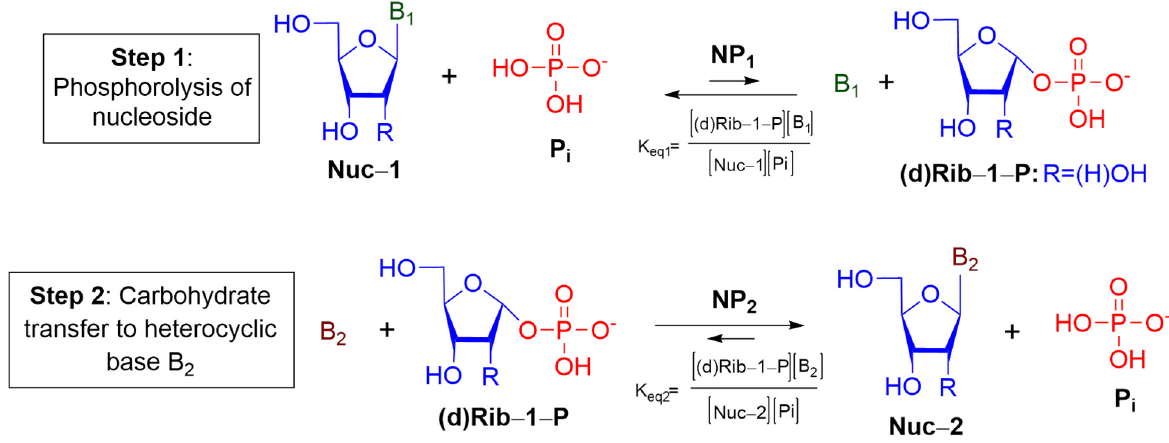
Figure 1. An enzymatic transglycosylation reaction consisting of two coupled phosphorolysis